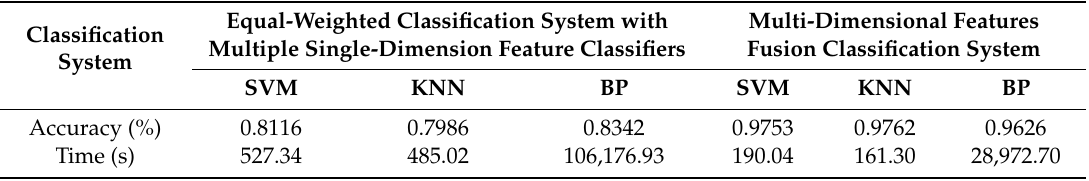
Table 5. Classification accuracy and time of automatic target recognition (ATR) classification system with two classification criterions and the SVM, KNN, and BP neural network three classifiers.